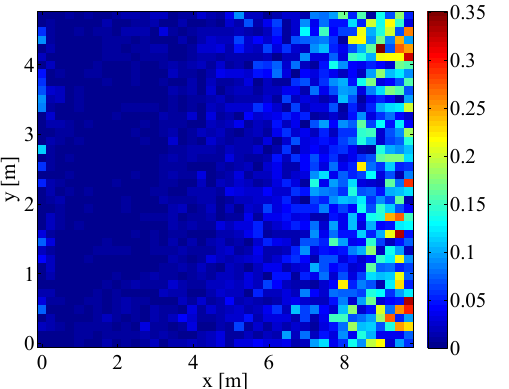
Figure 3. Simulation II: the plane where the transmitter with a height of 1m could move is discretized in 40 × 40 grid points result- ing in a resolution of about 0 . 24m in x direction and about 0 . 12m in y direction. Receivers are placed along the width of the ceiling and at the corners as in simulation I.